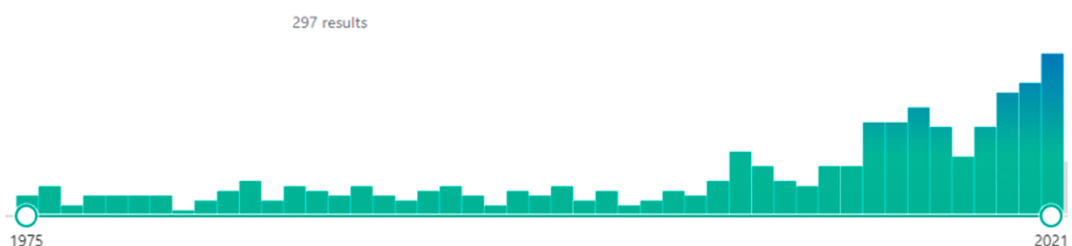
Figure 2. Diagram showing the articles available on PubMed when we reviewed the literature. One hundred and five articles were first selected for our global analysis. Then, only articles referring to anti-infective drugs were included (Table 1). Table 1. Number of screened articles and articles with no incorrect sentences over the timeline. Screening